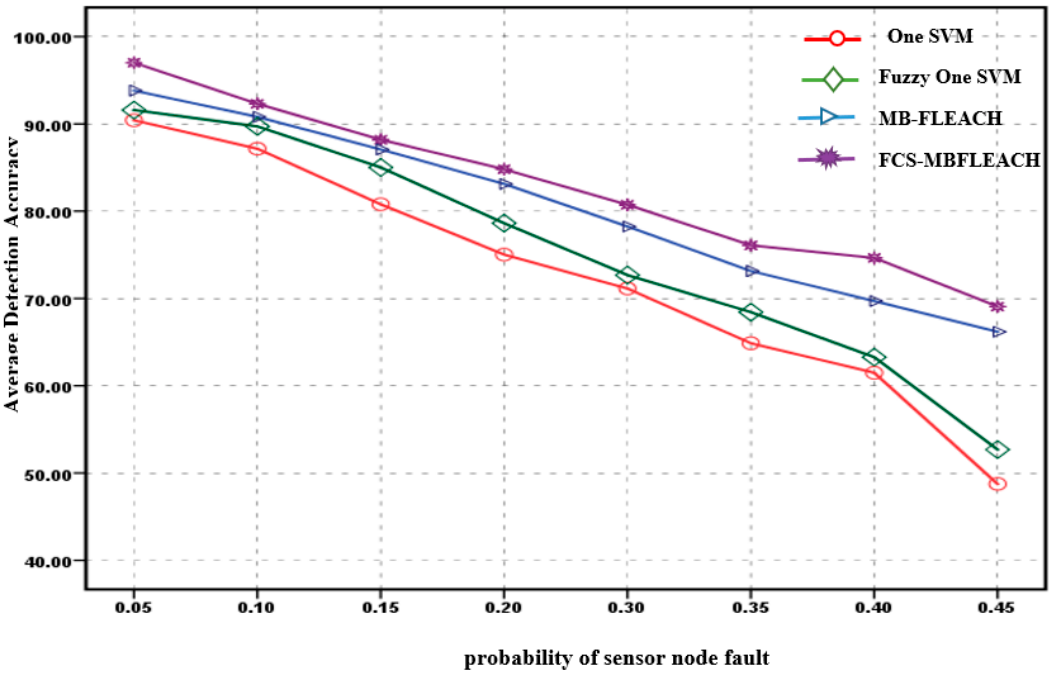
Figure 9. Average detection accuracy of sensor node faults with a density equal to five for the second scenario.